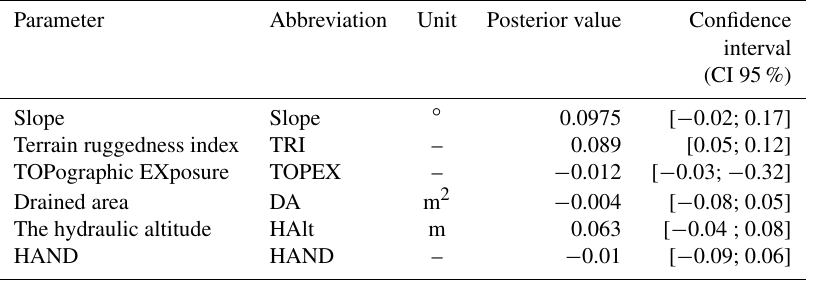
Table A3. List of environmental variables, abbreviations, units, and values of the posteriors in univariate models for a height threshold equal to the 0.01th percentile of the height distribution of the